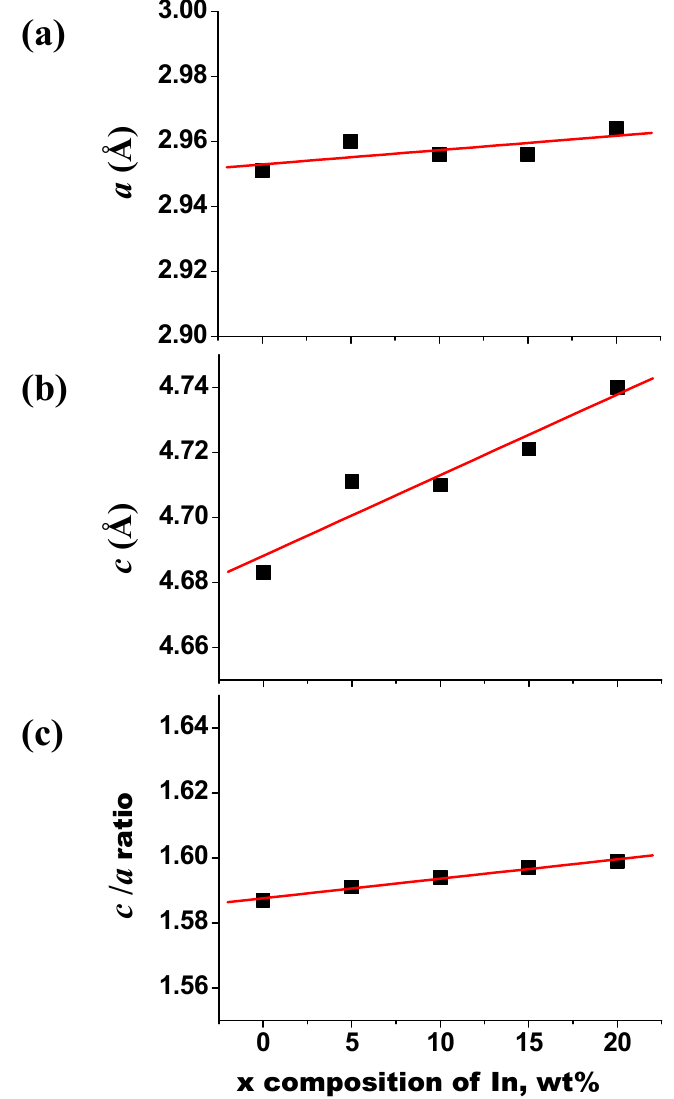
Figure 3. ( a , b ) Lattice parameters ( a and c ) of cp-Ti and Ti- x In alloys and ( c ) the variation in the ratio ( c / a ) of lattice